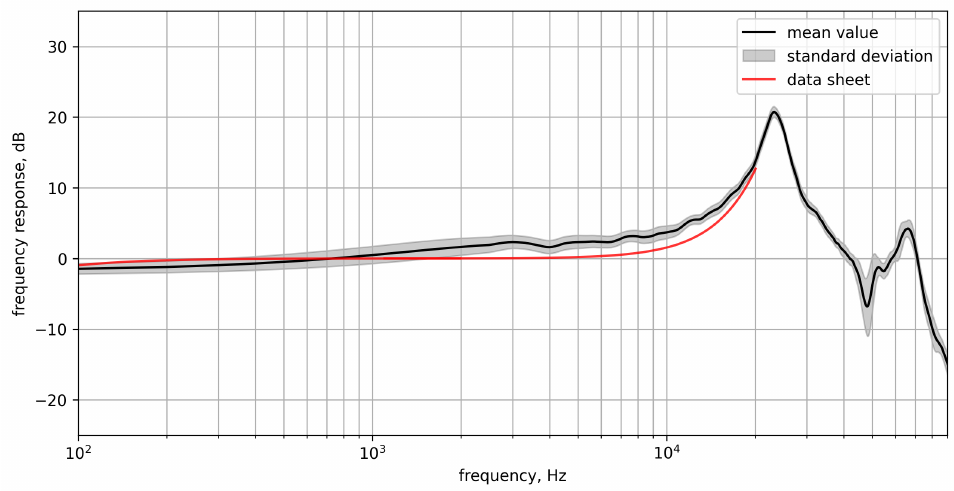
Figure 6. Mean frequency response of all array sensors with standard deviation in comparison to the data